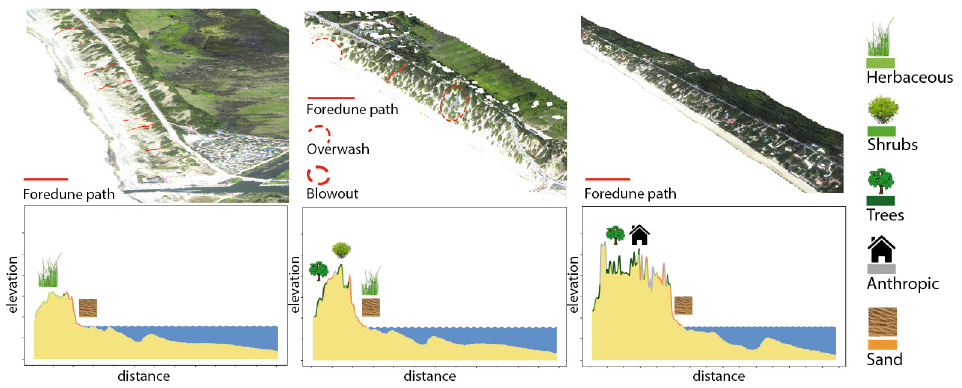
Figure 14. (top) 3D topographic LiDAR visualization of the beach–dune system from north to south and (down) corresponding details of the analyses provided by plotting on the DSM profiles the cover typologies (submerged beach profiles are also shown to give a better view of the system [66]).